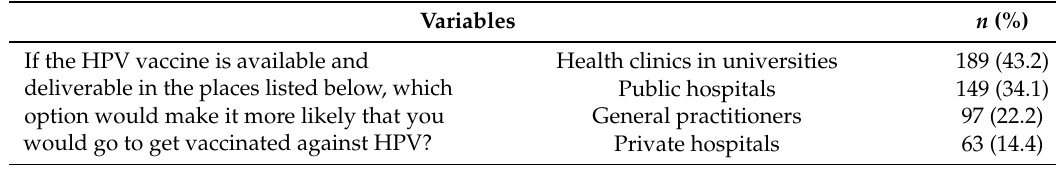
Table 3. Students’ acceptance of HPV vaccination.